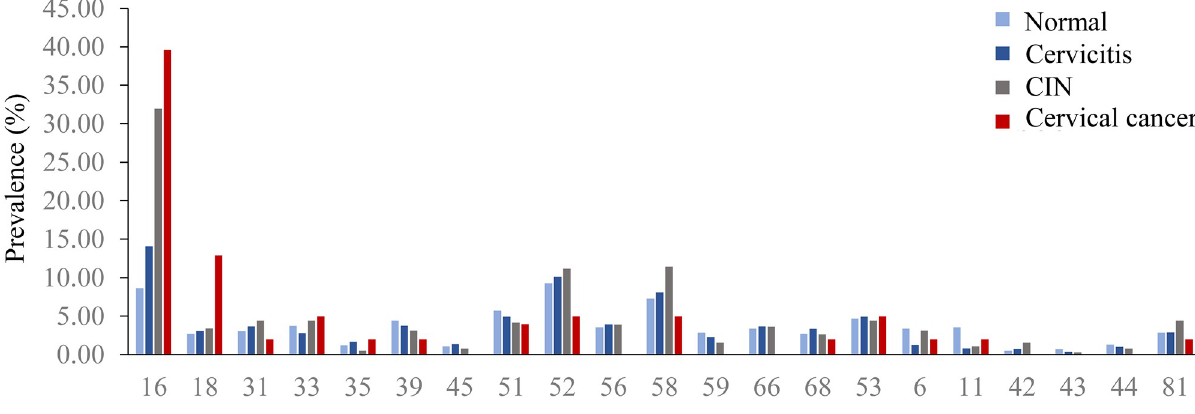
Fig 4. HPV prevalence associated with cervical